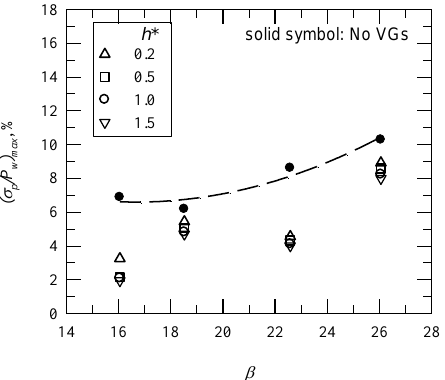
Figure 9. The effect of the height of VGs on peak pressure fluctuations.